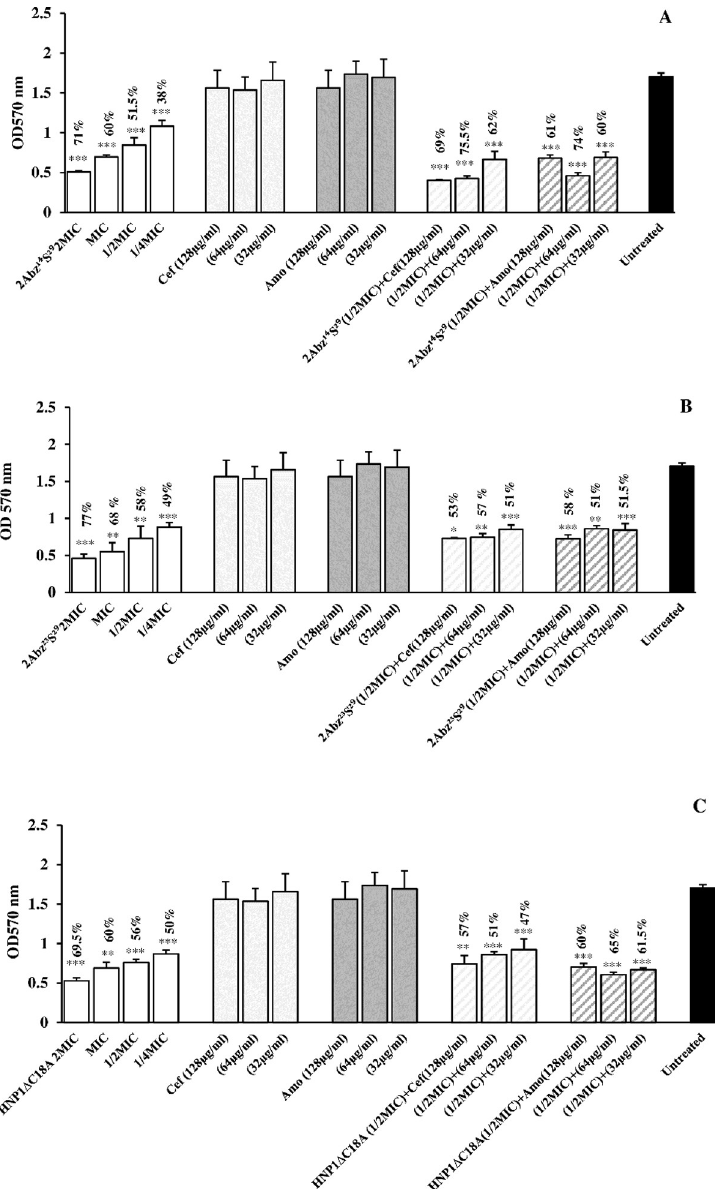
Fig 4. Biofilm inhibition by individual antimicrobial peptides (2Abz 14 S 29 , 2Abz 23 S 29 , and HNP1 Δ C18A), antibiotics (Cefixime and Amoxicillin) or their combination are shown in panels A, B, and C. Untreated bar indicates E . coli biofilm without any antimicrobial agent. Data show the means ± SD of three independent experiments. An asterisk indicates the statistically significant difference between antimicrobial agent and untreated control as measured by Student’s t-test ( � p < 0.05, �� p < 0.01 and ��� p < 0.001). Percent numbers indicate % reduction of